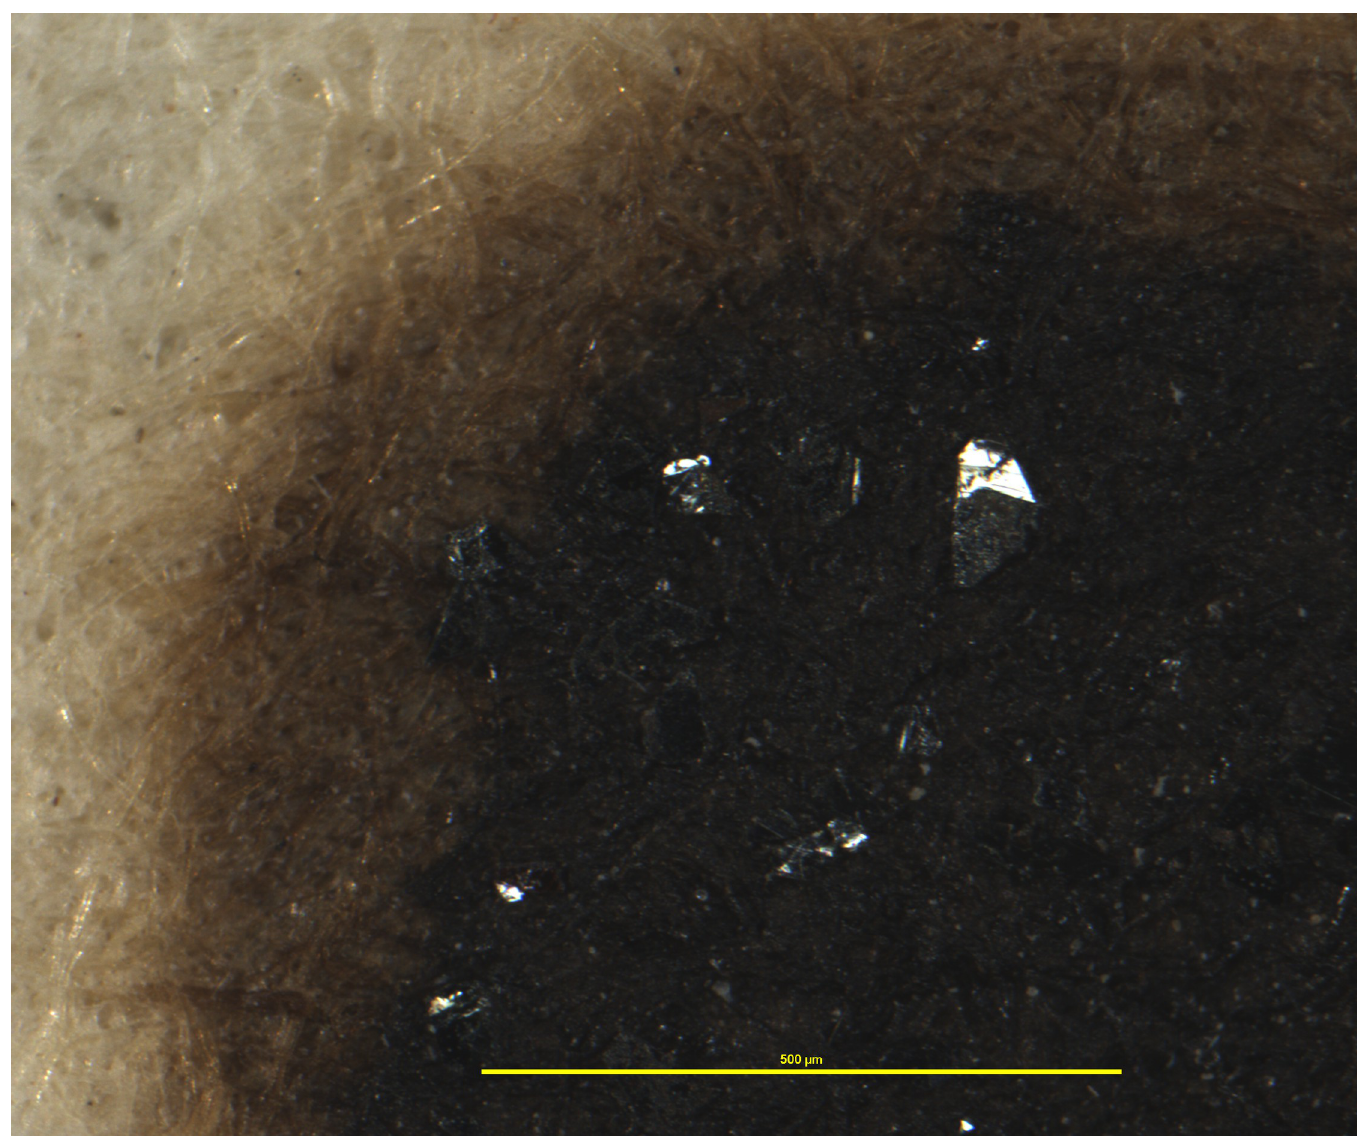
Fig 8. Ink sediments with reflective surfaces. Example of different sediment structures found on inks in the Azzolino collection, here black deposits with smooth, shiny surfaces. This particular document from volume K 427 of the Azzolino collection.